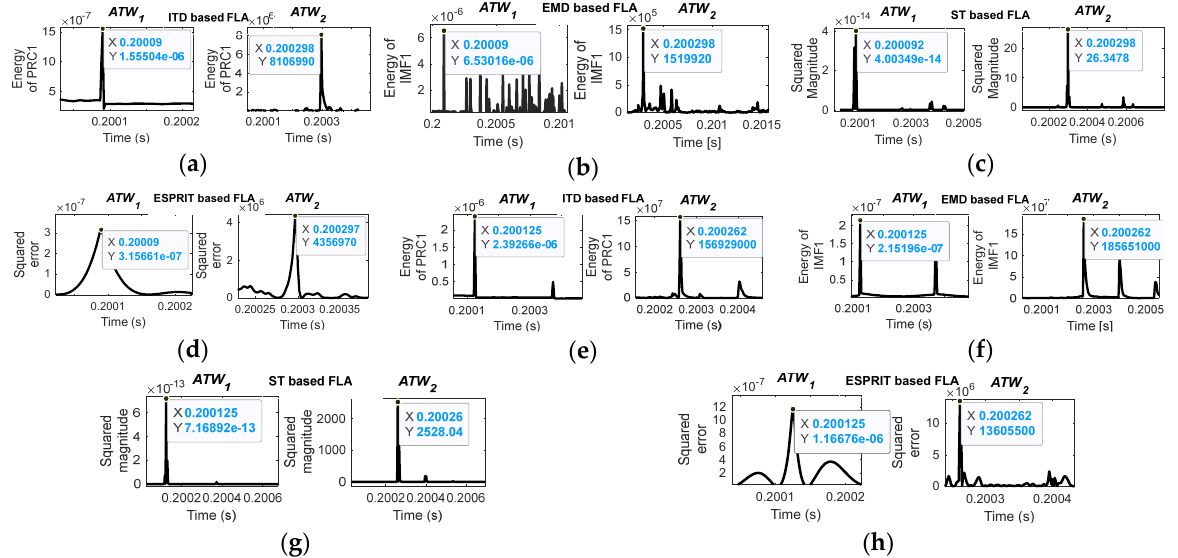
Figure 11. Estimation of ATWs for Kundur power system for faults before UPFC. ( a – d ) Estimated